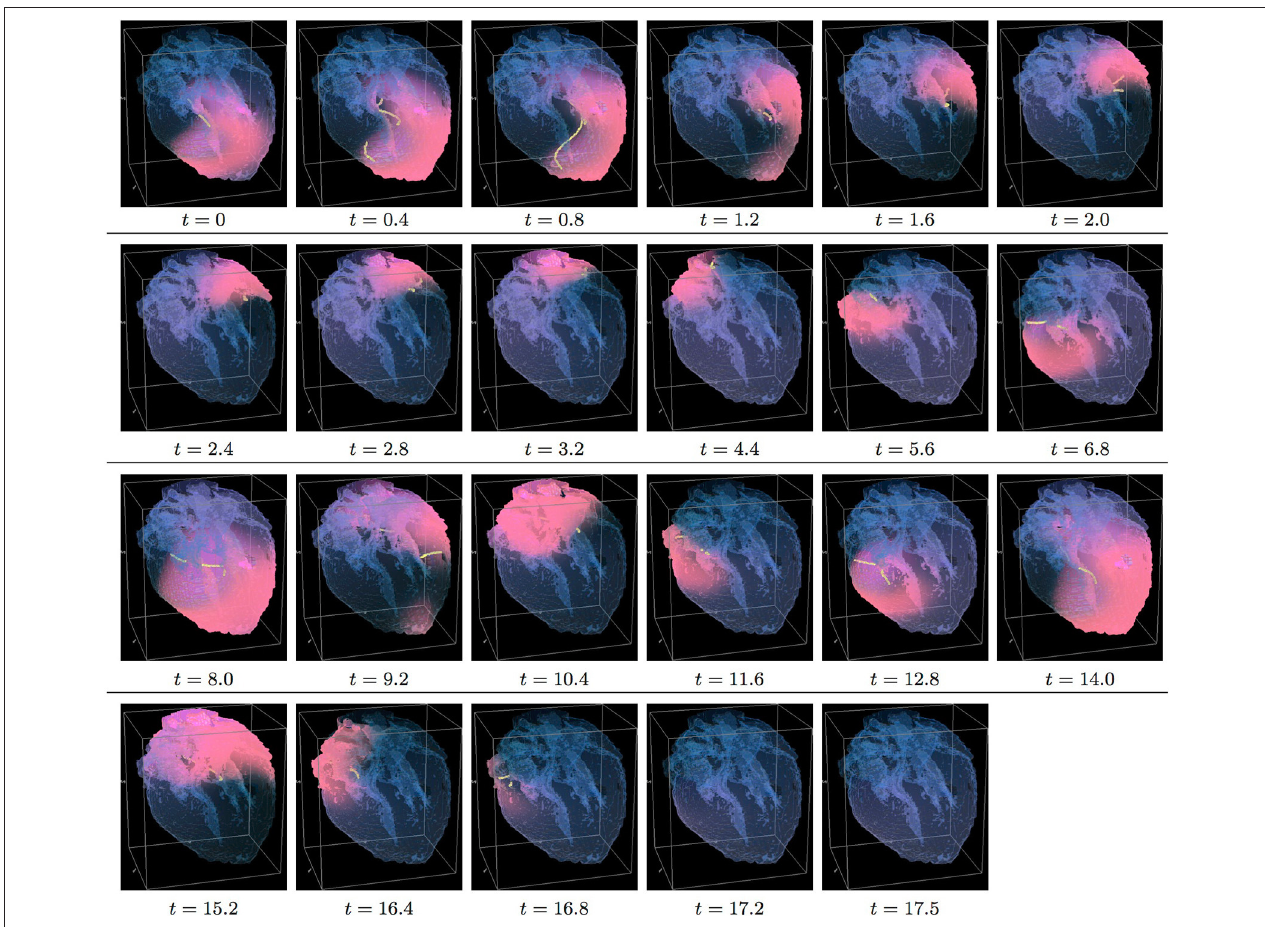
FIGURE 7 | Isotropic “edited” whole heart simulation. The translucent fetal heart is shown in blue, excitation front shown in red (see the color box in Figure 3 ), the yellow lines are the instant organizing filaments of the excitation vortices; time shown under each panel in time units of Equations (1, 2). After a short transient the organizing filament of the initial vortex breaks into the two short pieces each of which finds its own synchronous pathway, resulting after a few rotations in the synchronous termination of the filaments in the base of the fetal heart (See Supplementary Video 7 ).